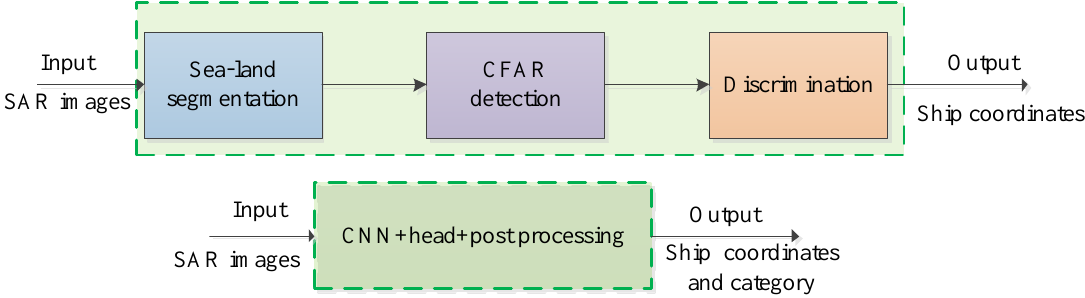
Figure 2. The differences between the CFAR-based detector and the deep learning-based detector.